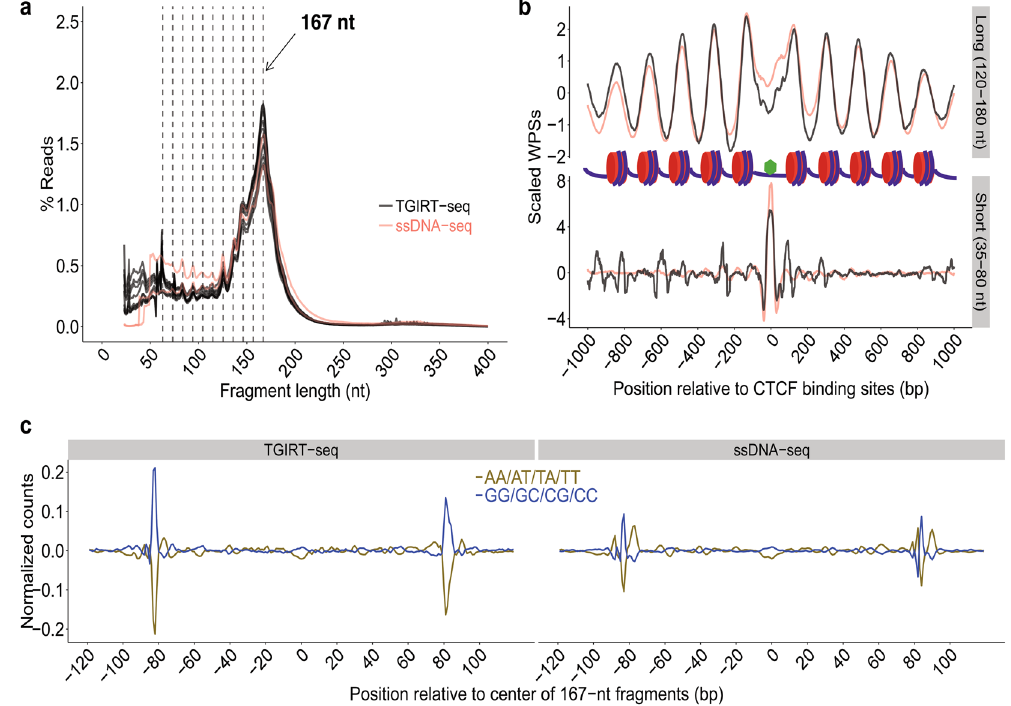
Figure 3. TGIRT ssDNA-seq of human plasma DNA enables analysis of nucleosome positioning and transcription factor-binding sites. Plasma DNA from a healthy male individual was sequenced by TGIRT-seq, and the resulting datasets (PD1-9; see Supplementary Table S3) were compared to those for plasma DNA from other healthy individuals sequenced by a conventional ssDNA-seq method (SRR2130051 and SRR2130052) 6 . (a) Fragment length distribution for TGIRT-seq (black lines; 9 datasets for a healthy male individual) and conventional ssDNA-seq (pink lines; 2 datasets, one for a male and the other for a female individual). The peaks at 167 nt reflect DNA that is protected from cleavage by endogenous DNases by packaging in nucleosomes. The vertical dashed lines indicate subpeaks with a periodicity of ~10.4 nt protected from endogenous DNase I nicking of exposed regions of dsDNA in nucleosome 6,38 . (b) Meta-analysis of scaled window protection scores (WPSs) within ± 1 kb of all annotated binding sites for transcription factor CTCF (green hexagon) in healthy male individuals analyzed by TGIRT-seq and ssDNA-seq. TGIRT-seq (black line; combined datasets from 9 libraries) and conventional ssDNA (pink line; healthy male individual, SRR2130051) show similarly protected DNA regions both for longer DNA fragments (120–180 nt) protected in nucleosome cores and shorter DNA fragments (35–80 nt) protected by bound transcription factor CTCF (top and bottom graphs, respectively). (c) Dinucleotide frequencies as a function of nucleotide position across 240-bp genomic windows centered at the mid-point of 167-nt DNA fragments for TGIRT-seq (left; combined datasets for 9 replicates) and conventional ssDNA-seq (right; healthy male individual; SRR2130051). Dinucleotide frequencies were extracted from the datasets by a customized script and normalized by using a median filter with a window size of 101